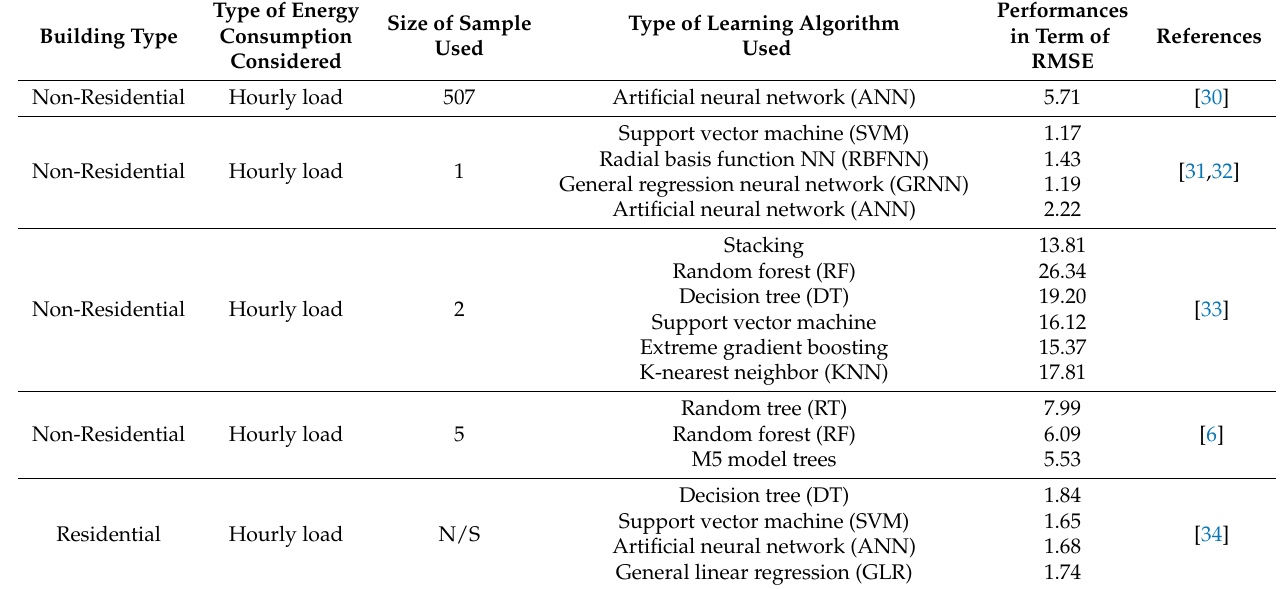
Table 1. Machine learning methods for energy prediction in the